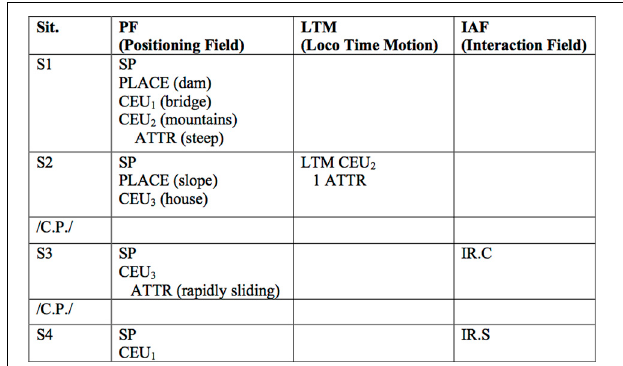
FIGURE 6 | Moser and von Zeppelin dream coding sheet. SNbr, Situation (dream-scene); /C.P./, cognitive process (Interrupt); SP, self processor (dreamer); CEU, cognitive element inanimate; ATTR, attribute; IR.C, interactive relation connecting; IR.S, interactive relation